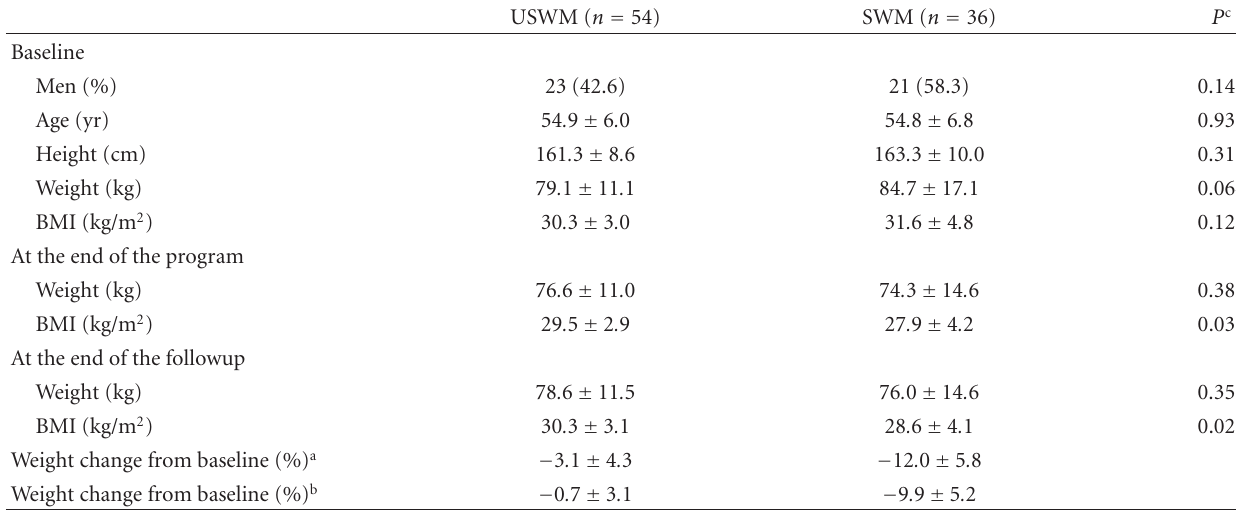
Table 1: Comparison of baseline characteristics and changes in weight and BMI.